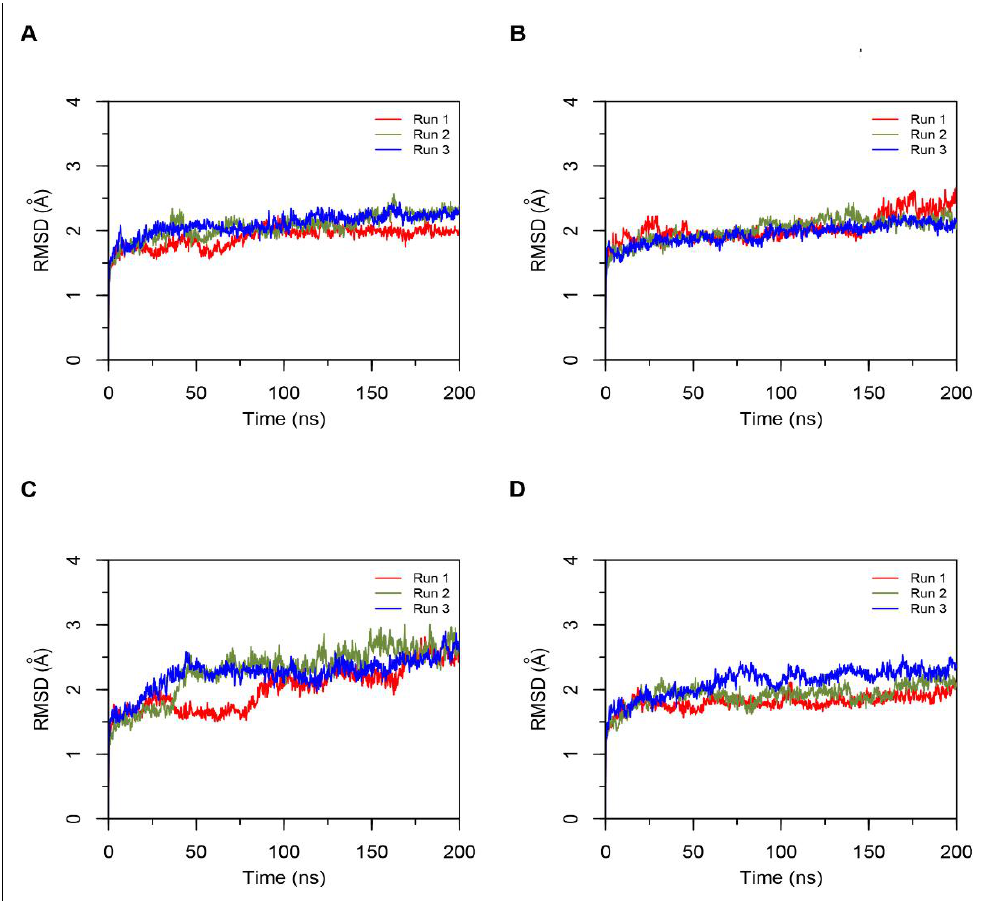
Figure 3. Root mean square standard deviation (RMSD) of protein Cα atoms obtained from three independent 200 ns runs of hemorphin bound ACE simulations. Data from the three runs are shown in red, green and blue. ( A ) Simulations of ACE-LVVYPWTQRF complex; ( B) Simulations of ACE-LVVYPWTRRF complex; ( C ) Simulations of ACE-YPWTQRF complex; and, ( D) Simulations of ACE-YPWTRRF complex.